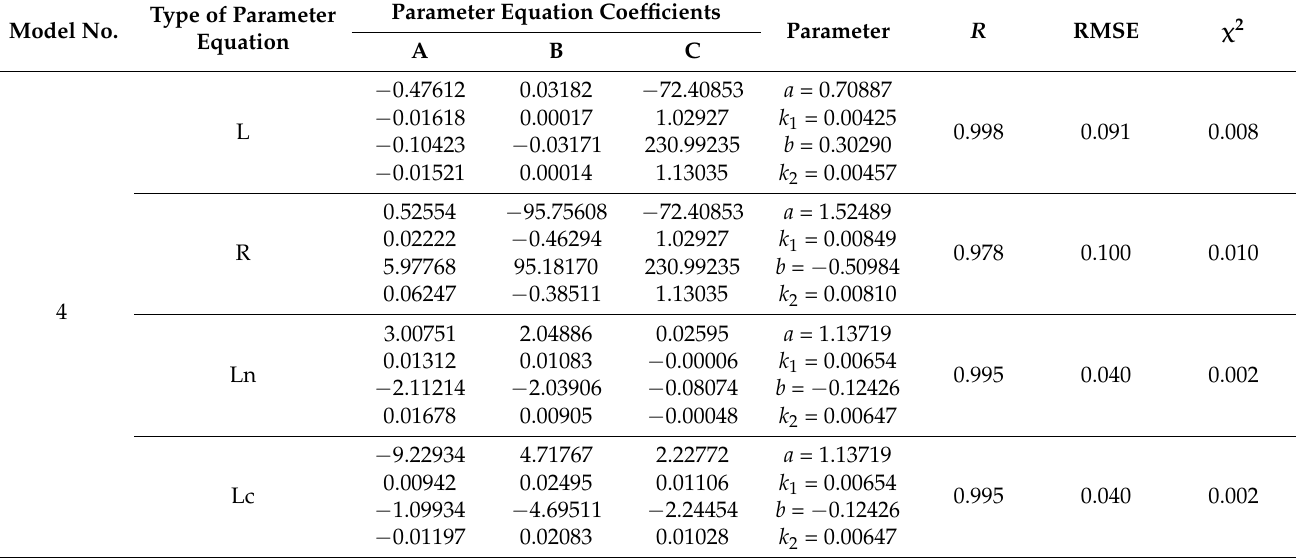
Table 3. Parameter equation coefficients for selected semi-theoretical and empirical models of sawdust drying, and comparison of results of statistical analyses regarding modelling of willow dried at air temperature of 60 ◦ C and airflow velocity of 0.01